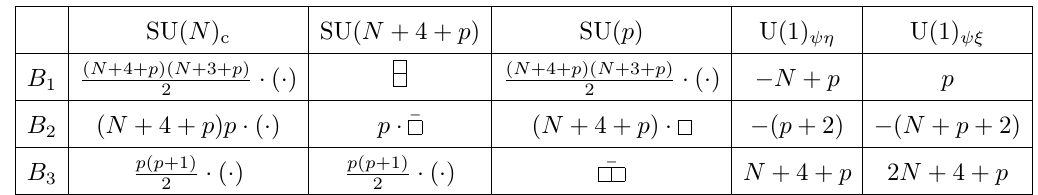
Table 5 . The multiplicity, charges and the representation are shown for each set of fermions in the BY model.